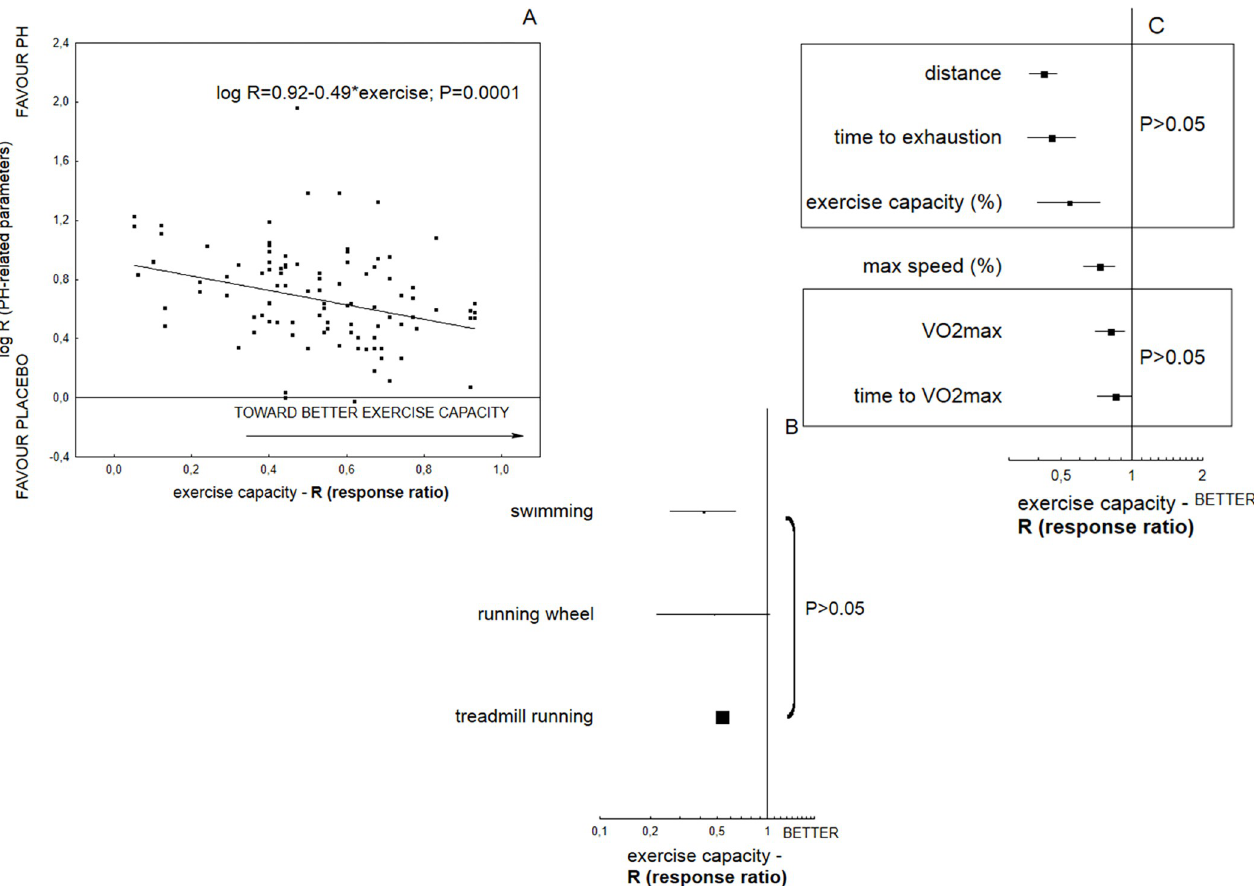
Fig 3. The performance of animals with pulmonary hypertension in relation to methods used for the assessment of animal exercise capacity. The overall effect was expressed as response ratio (R), according to alterations in both hemodynamic (RVSP, mPAP) and remodeling parameters (Fulton index, PA muscularization), as well as animal exercise capacity. The increased values of response ratio (R) reveal better exercise endurance ( n = 1955 animals). A statistically significant Q measure (P < 0.05) indicates heterogeneity among two or more analyzed subgroups. Meta-regression plot ( 124 comparisons ) demonstrates that worsening of PH-related parameters was significantly correlated with poorer animal exercise capacity (P = 0.0001) ( A ); the method chosen for the exercise tests had no influence on the resultant changes in exercise capacity (Q = 0.59; df = 2; P > 0.05) ( B ); among a wide range of parameters that could be detected in the analyzed experiments, a similar exercise capacity ( C ) was observed where the following sets of parameters were considered: distance, time to exhaustion and percentage exercise capacity (Q = 2.1; df = 2; P > 0.05) or values of VO 2 max and time to VO 2 max (Q = 0.19; df = 1; P > 0.05).